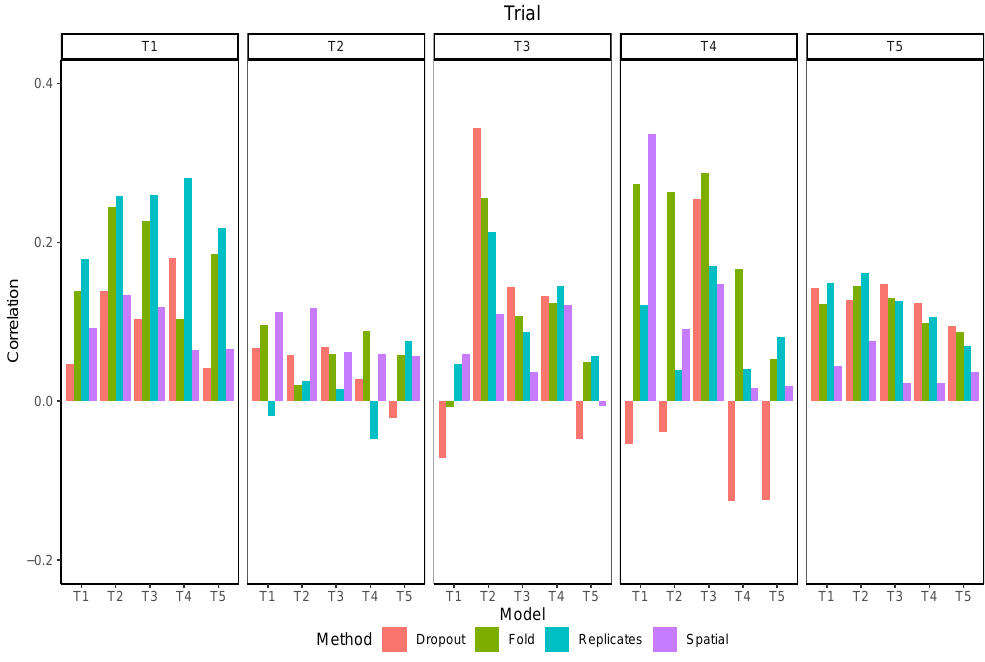
Figure 13. Correlation between the standard deviation and the absolute error of maturity predictions using different methods to estimate